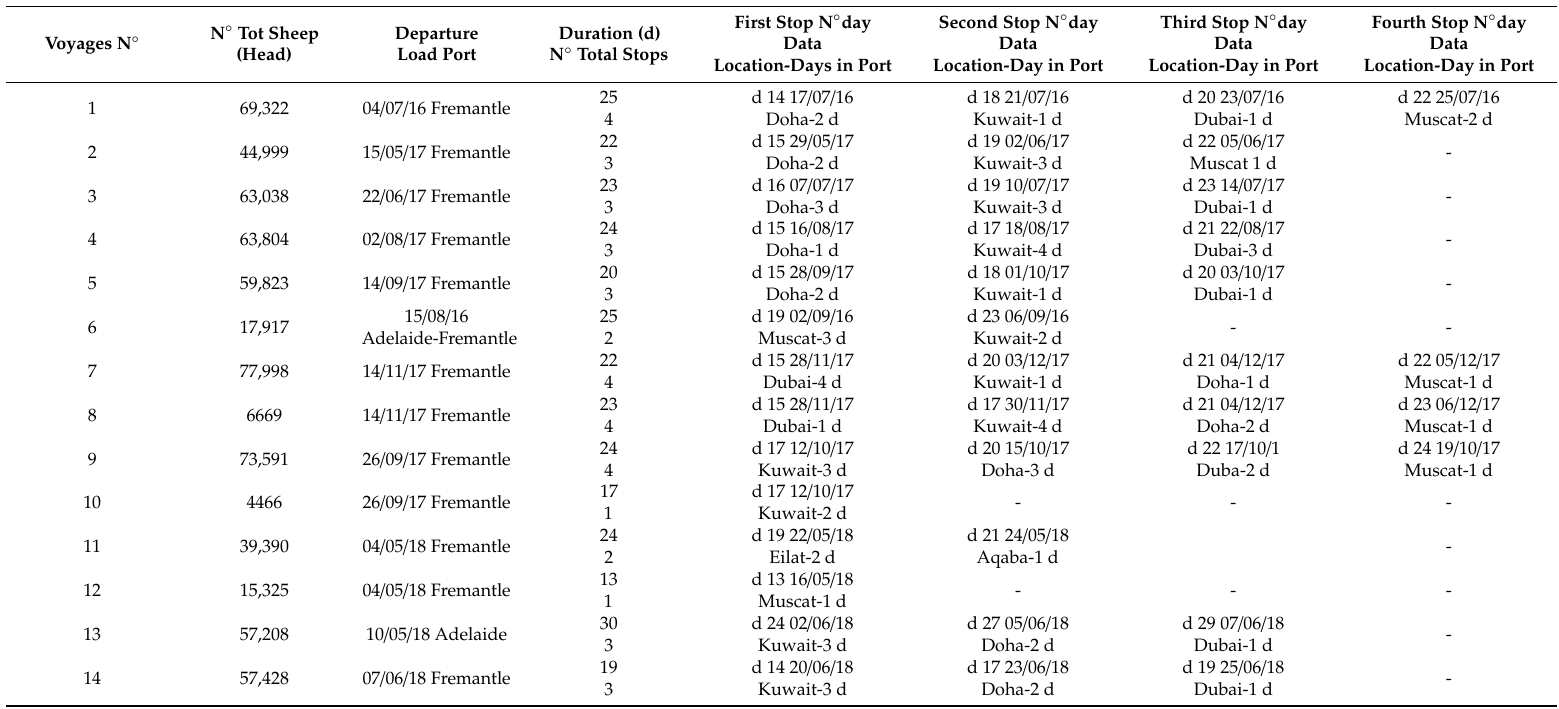
Table A1. Summary table of information relating to the 14 trips studied; duration of voyages, specifying the various ports and the time spent unloading sheep with an average of 1.95